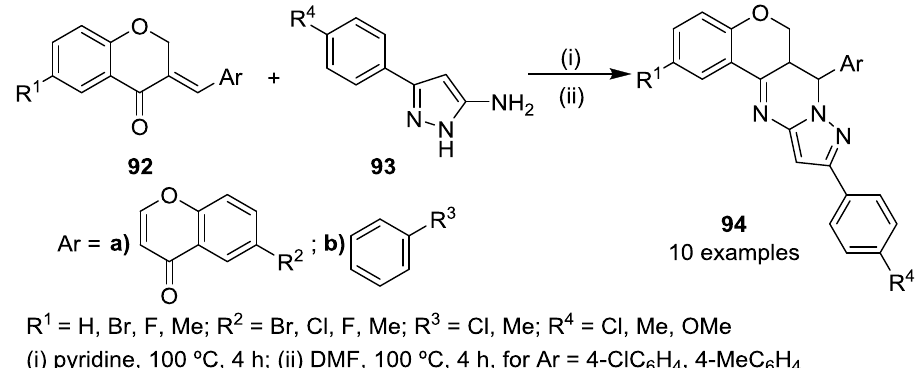
2-amino-3-carbamoylchromone 89 with hydrazines [57].